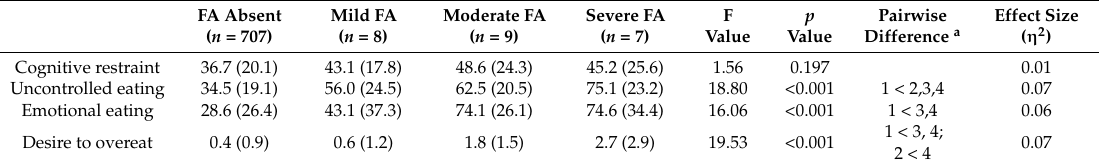
Table 5. Associations of the 18-item Three-Factor Eating Questionnaire (TFEQ R-18) scores and frequency of desiring to overeat with the J-YFAS 2.0-diagnosed food addiction (FA) absence/presence. t p FA Absent FA Present Effect Size (d) ( n = 707) ( n = 24) Value Value Cognitive restraint 36.7 (20.1) 45.7 (21.7) − 2.097 0.036 0.44 Uncontrolled eating 34.5 (19.1) 64.1 (23.1) − 7.246 <0.001 1.54 Emotional eating 28.6 (26.4) 63.9 (34.6) − 4.959 <0.001 1.32 Desire to overeat 0.41 (0.91) 1.7 (2.0) − 2.965 0.007 1.28